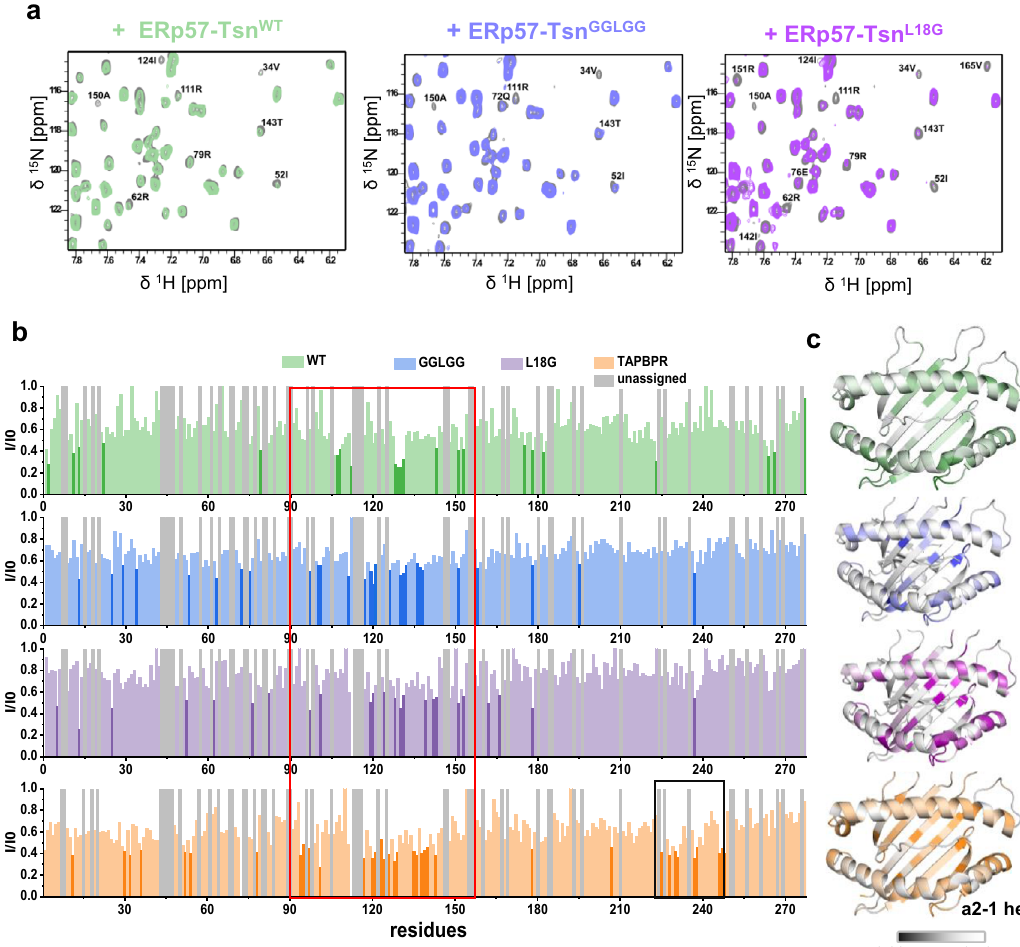
Fig. 5 NMR analysis of tapasin mutants interacting with MHC-I. a Representative zoom view of the overlay of 1 H- 15 N TROSY-HSQC spectra of 50 µ M B*27:09/photoRL9 (gray) and in the presence of equimolar ERp57-Tsn WT (green), ERp57-Tsn GGLGG (blue) or ERp57-Tsn L18G (purple). Attenuated peaks are marked. b Peak intensity ratio analysis (I/I0) of B*27:09/photoRL9 in the presence of ERp57-Tsn WT , ERp57-Tsn L18G , ERp57-Tsn GGLGG , and TAPBPR against B*27:09/photoRL9 (I0) are plotted against residue sequence. Signi fi cantly reduced residues (below I/I0 average – δ ) were highlighted in corresponding dark color. Unassigned residues are plotted as gray bars. Red squared region means affected region in the peptide binding groove in the presence of tapasin or TAPBPR. Black squared region means region only affected by TAPPBR. c Peak intensity ratio (I/I0) are mapped as B-factor on the structure of B*27:09. The range of the intensity ratio is from 0.3 to 0.7 for all mutants. The color code is the same as in b . Unassigned residues are plotted as white